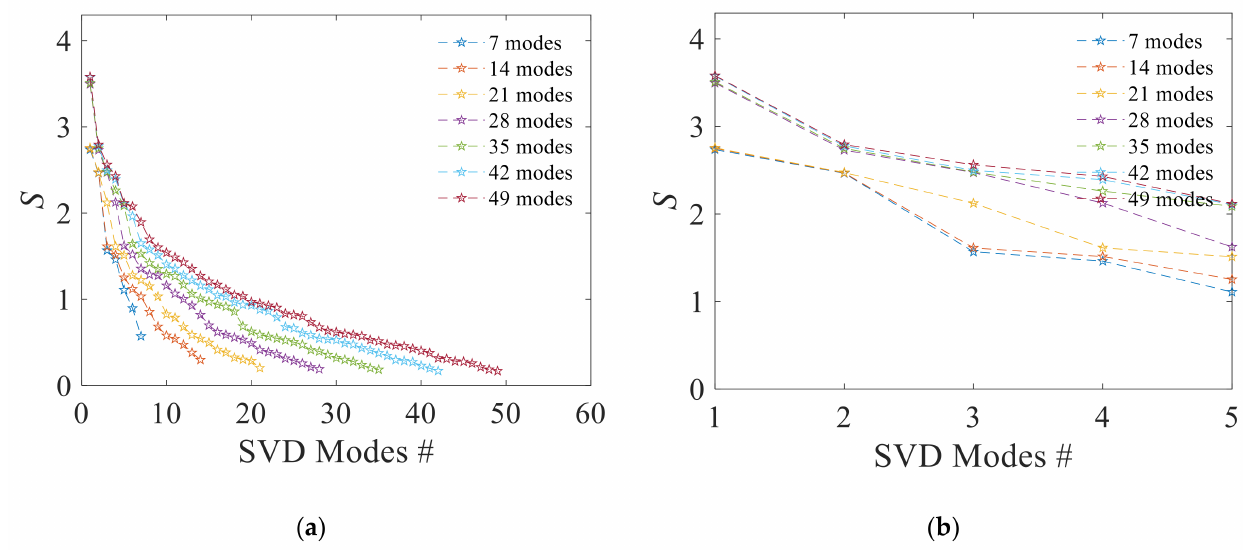
Figure 4. Singular values, S , variation depending on the number of modes: overview ( a ), zoom view ( b ). Figures 5 and 6 show a comparison between six modes estimated by SVD (i.e., eigen- vectors plot) and structural modes (i.e., test model scale) estimated by